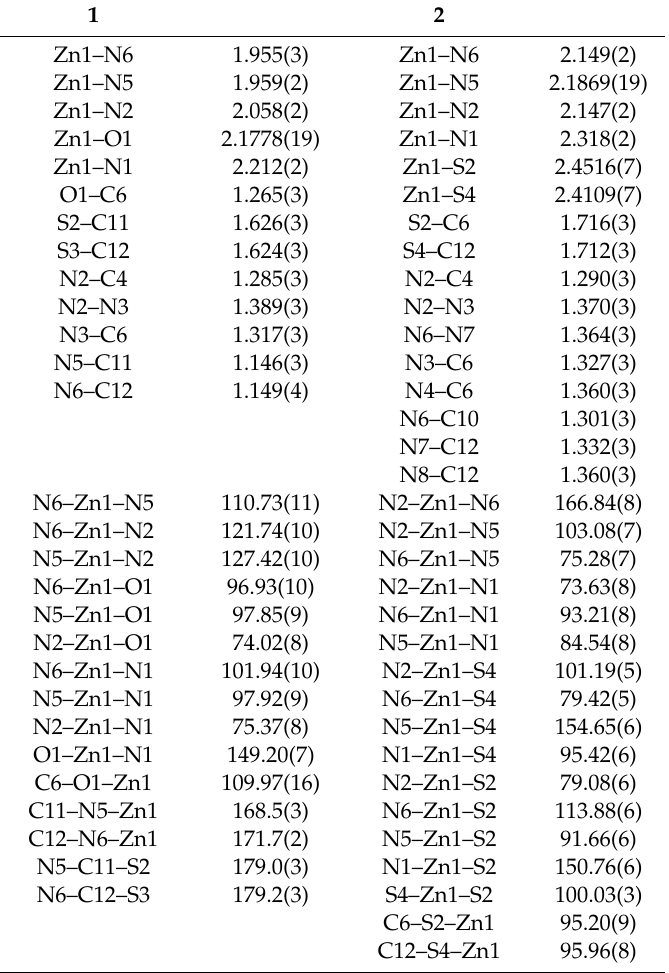
Table 1. Selected bond lengths (Å) and angles ( ◦ ) for 1 and 2 .